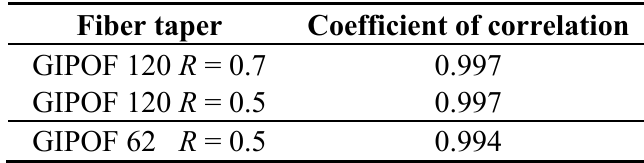
Table 1. Least squares regression of absorbance versus square root of concentration.